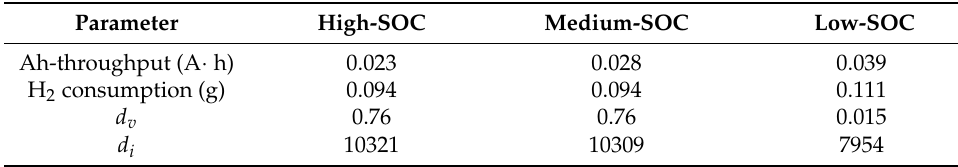
Table 12. Performance parameters of the full-active hybrid simulation. Parameter